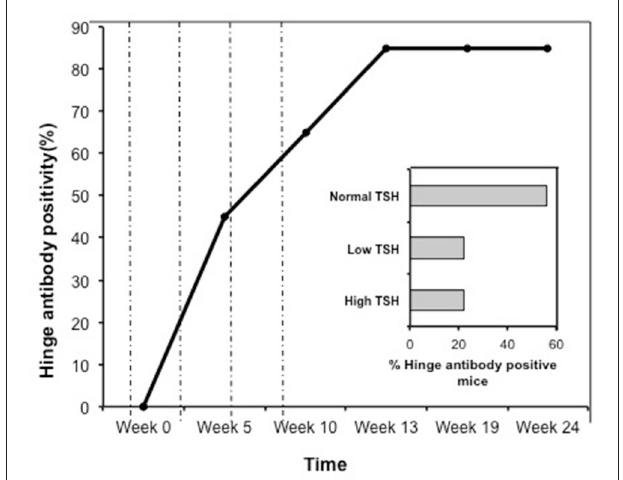
FIGURE 6 | Time course of response to hinge region “hot-spots” in immunize mice. Mice immunized with full-length hTSHR showed increasing antibody response to the hinge region “hot-spots” throughout the time course of the immunization described in Figure 1. As indicated here an antibody rise started as early as < 5 weeks and plateaued off at week 13 maintaining 85% positivity until the termination of the experiment. Dotted lines indicate immunization time points. Insert: Shows the percentage of hinge region “hot-spot” antibody positive mice by thyroid function at week 10. 56% of the antibody positive mice were in the normal TSH range and 22% were in each of the low and high TSH ranges.